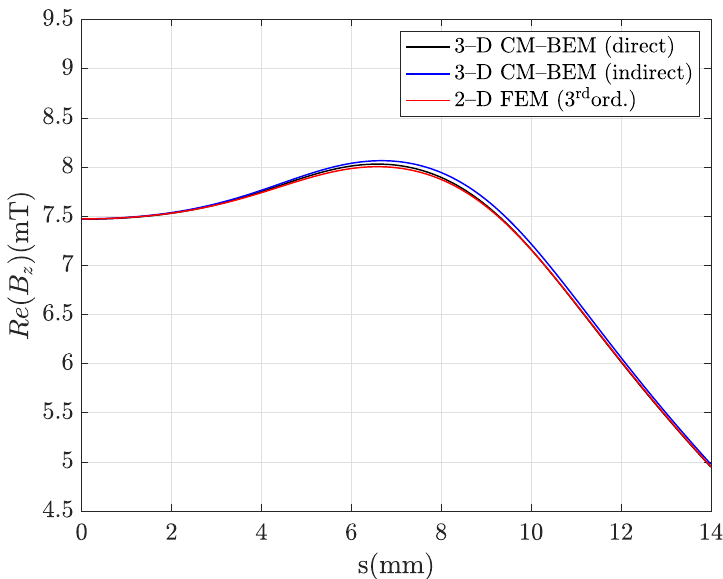
Figure 9. Real part of the axial magnetic flux density component along line C-D (black line: direct formulation, blue line: indirect formulation, red line: 2D FEM, taken as a reference).